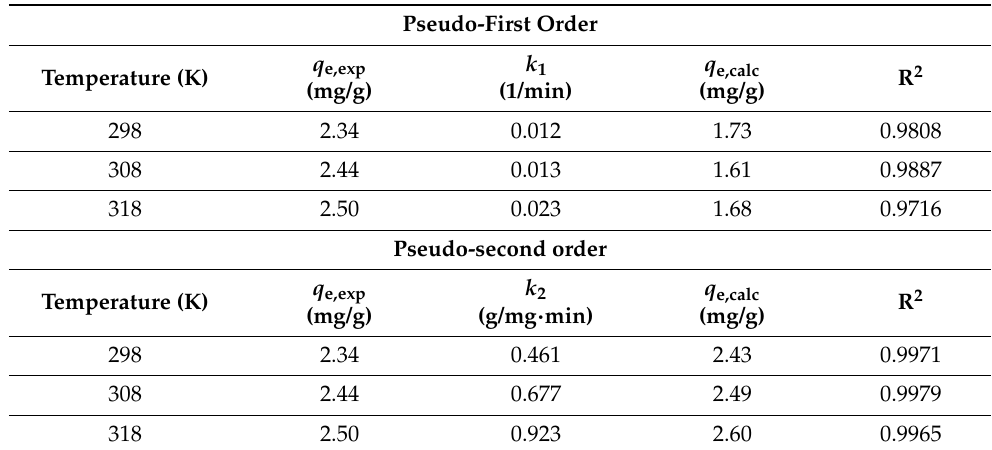
Figure 8. Pseudo-first order (a) and pseudo-second order (b) kinetic isotherms. Table 1. Kinetic parameters for the adsorption of Ru(III) onto Ch-DB30C10.